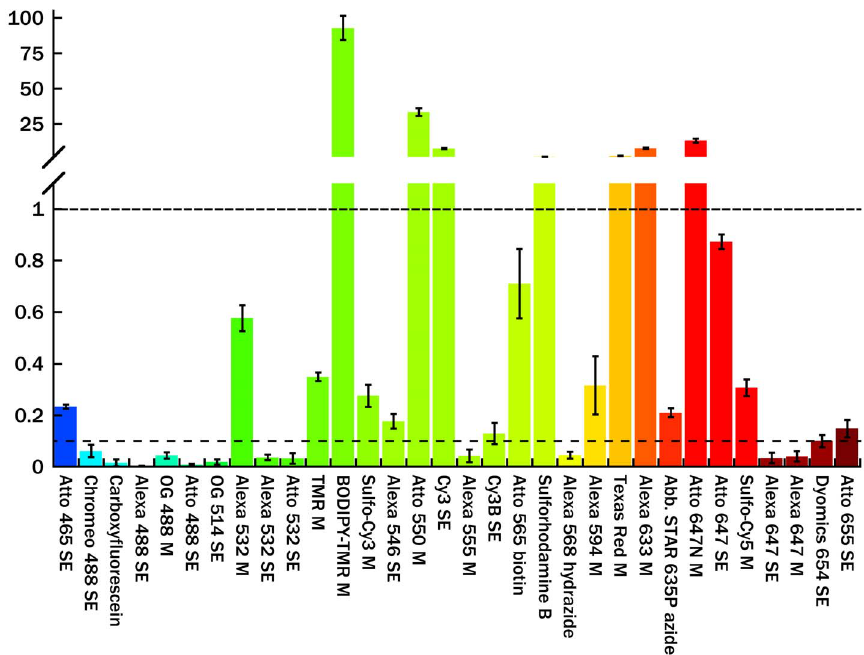
Figure 2. Bar graph of membrane interaction factors (MIF, Table 1), sorted by excitation maximum. Dyes below the bottom dashed line (MIF , 0.1) exhibit little to no association with Egg PC lipid bilayers, while dyes above the second dashed line (MIF . 1) strongly associate with membranes. Note that the y-axis changes substantially at MIF . 1.1. Each data point represents the average of three independent measurements, 6 propagated error of the standard deviation.